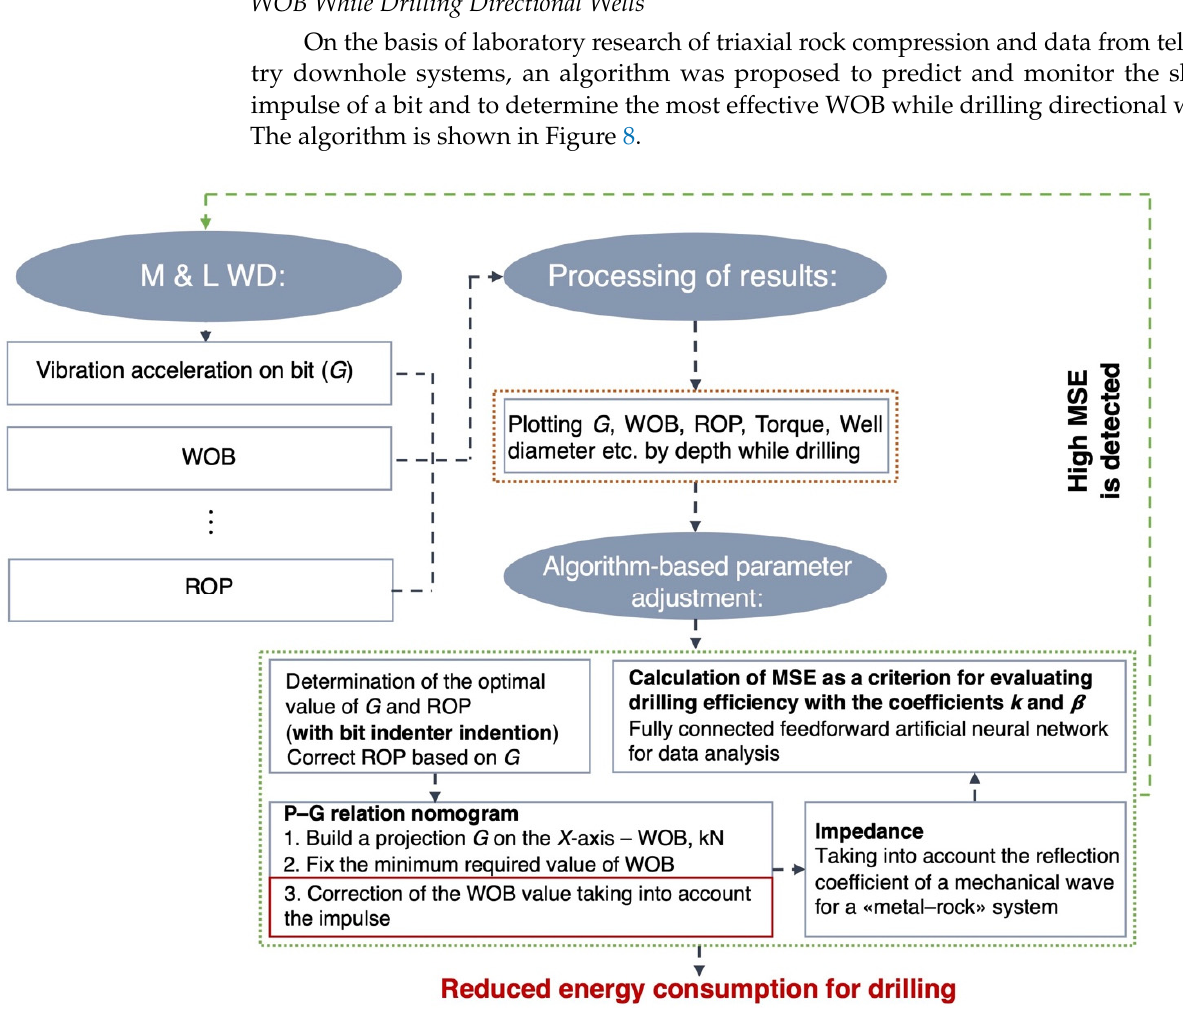
Figure 8. Algorithm for determining the effective use of MSE.